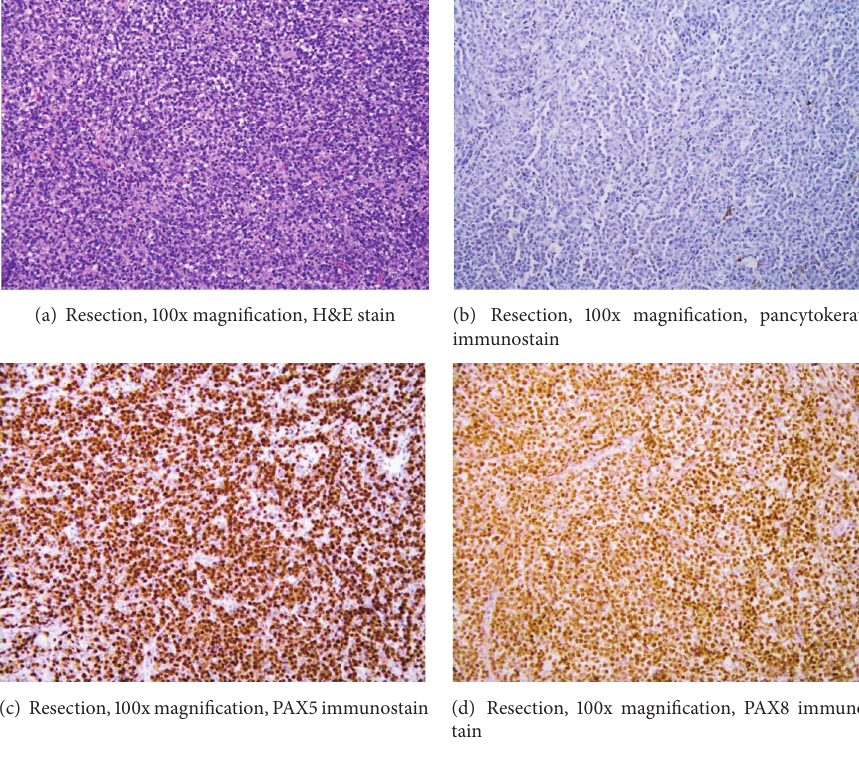
Figure 4: Isthmusectomy specimen demonstrates sheets of malignant cells displacing thyroid follicles; neoplasm is clearly pancytokeratin- negative with coexpression of PAX5 and polyclonal PAX8